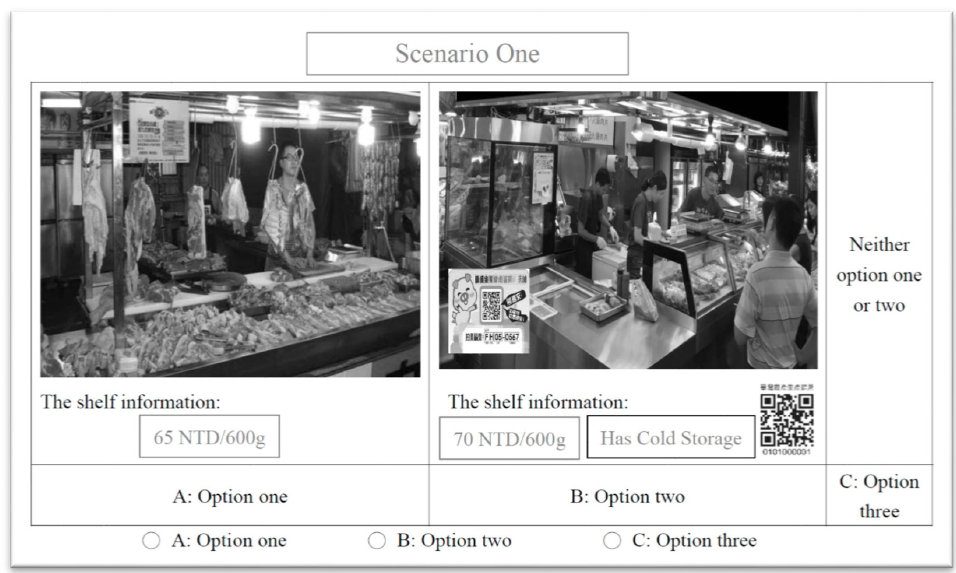
Figure 1. The example of a choice set.